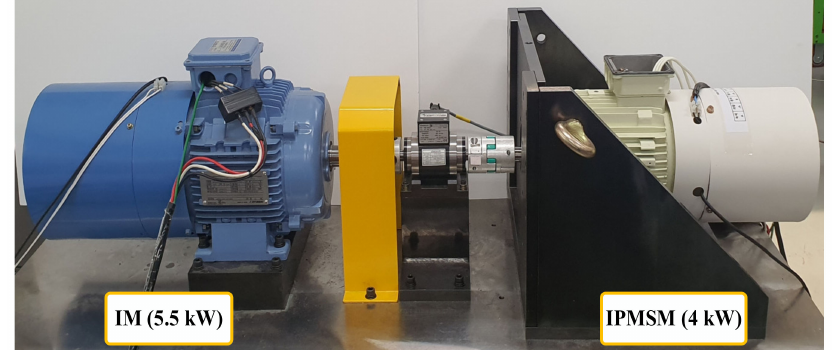
Figure 12. M-G set for the experiment.